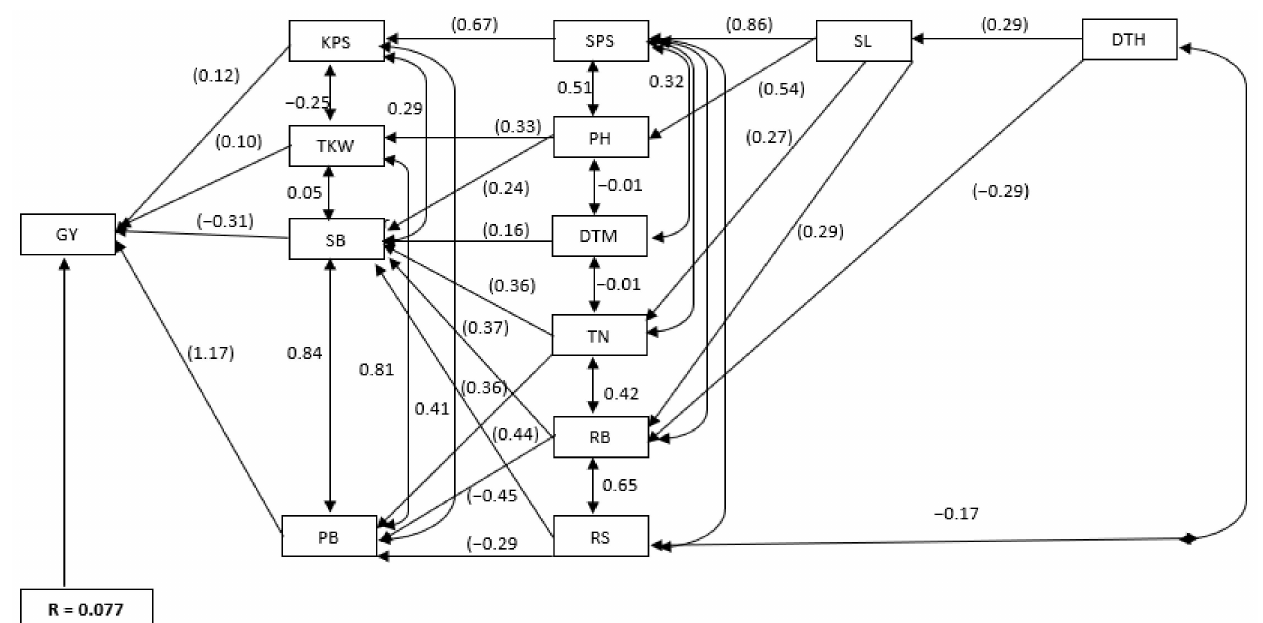
Figure 4. Path analysis model diagram displaying causal relationships of assessed traits on grain yield in 10 bread wheat parental lines and 90 derived F 2 families of wheat assessed under non-stressed conditions. Values in parenthesis are direct path coefficients, while other values are correlation coefficients. R = residual effect; DTH = days to 50% heading, DTM = days to 50% maturity, PH = plant height (cm), TN = tiller number, SL = spike length (cm), SPS = spikelets per spike, KPS = kernels per spike, TKW = thousand kernel weight (g), SB = shoot biomass (g · m − 2 ), RB = root biomass (g · m − 2